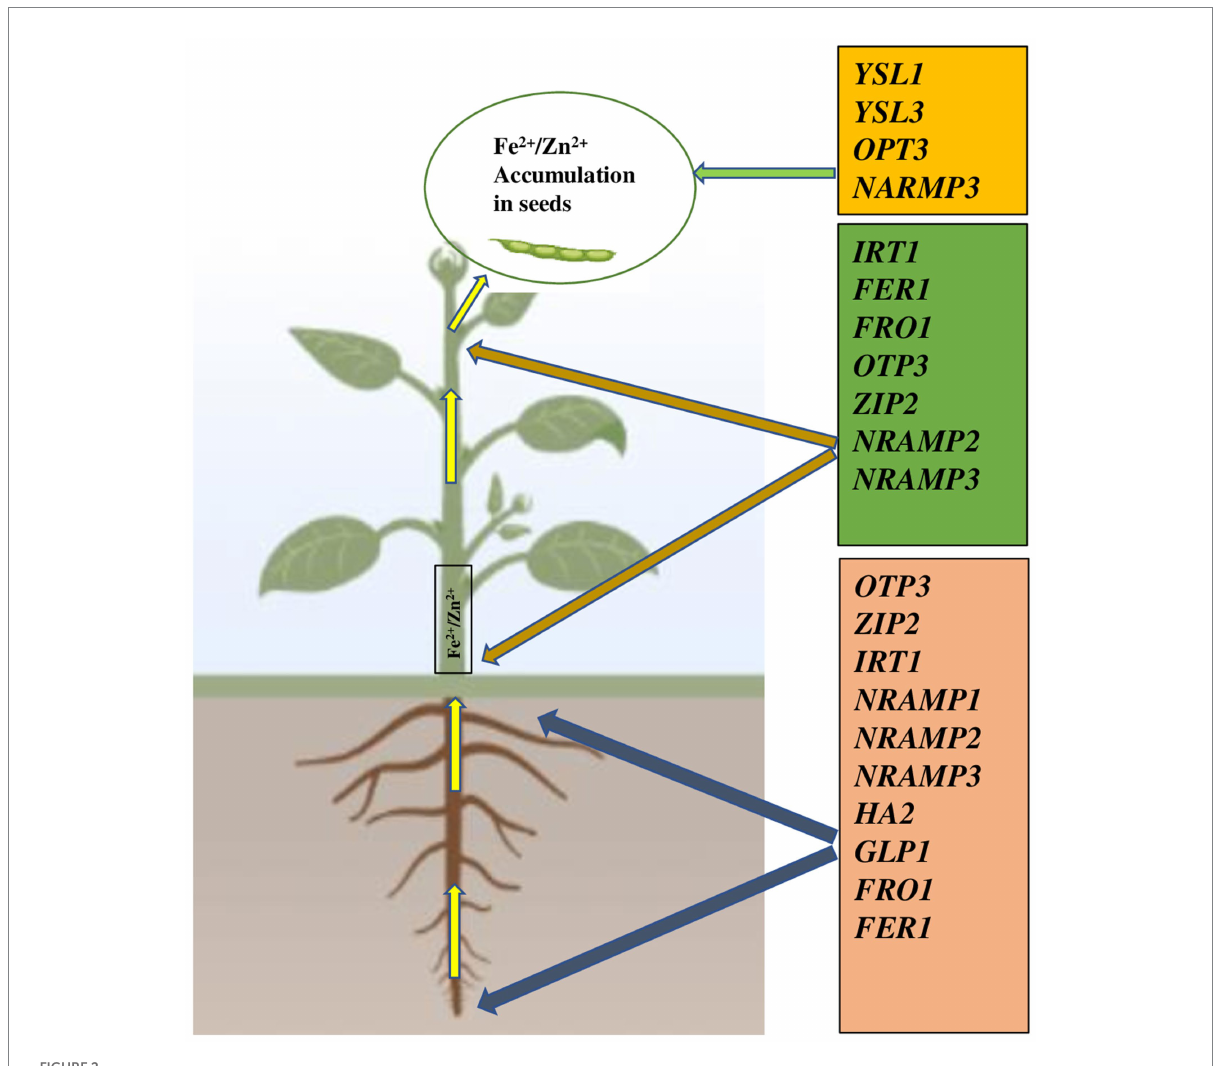
FIGURE 2 Gene families involved in translocation and accumulation of Fe 2+ /Zn 2+ in seed of common bean (Urwat et al., 2021). YSL1 and YSL3 genes are involved in unloading minerals to seeds. YSL, Yellow Stripe Like; OPT, Oligopeptide transporter; NRAMP, Natural resistance-associated macrophage protein; IRT, Iron regulated transporter; FER, Ferritin; FRO Ferric reduction oxidase; ZIP, Zinc induced protein; HA, H+ transporting ATPase; GLP, Germin like protein. Plant images made with Biorender